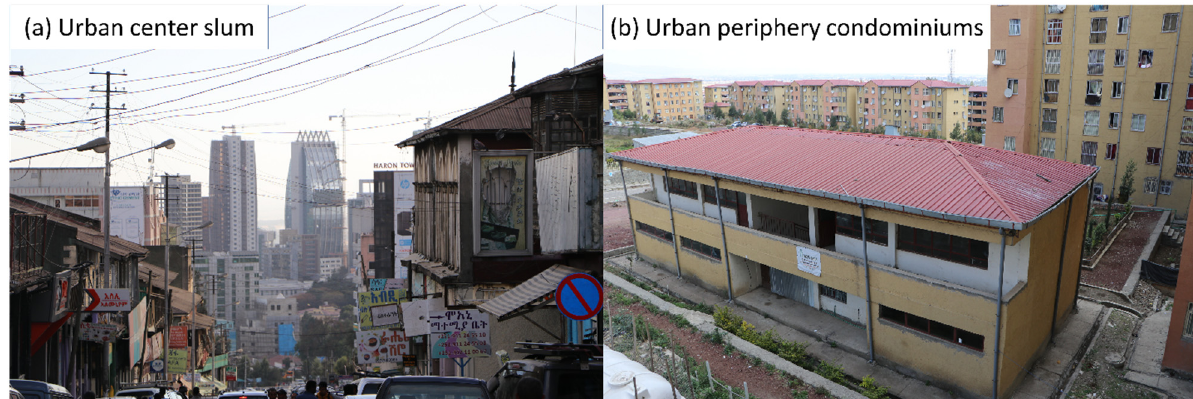
Figure 19. Addis Ababa’s central core urban renewal (demolition) and urban expansion towards the periphery between 1991 and 2020.